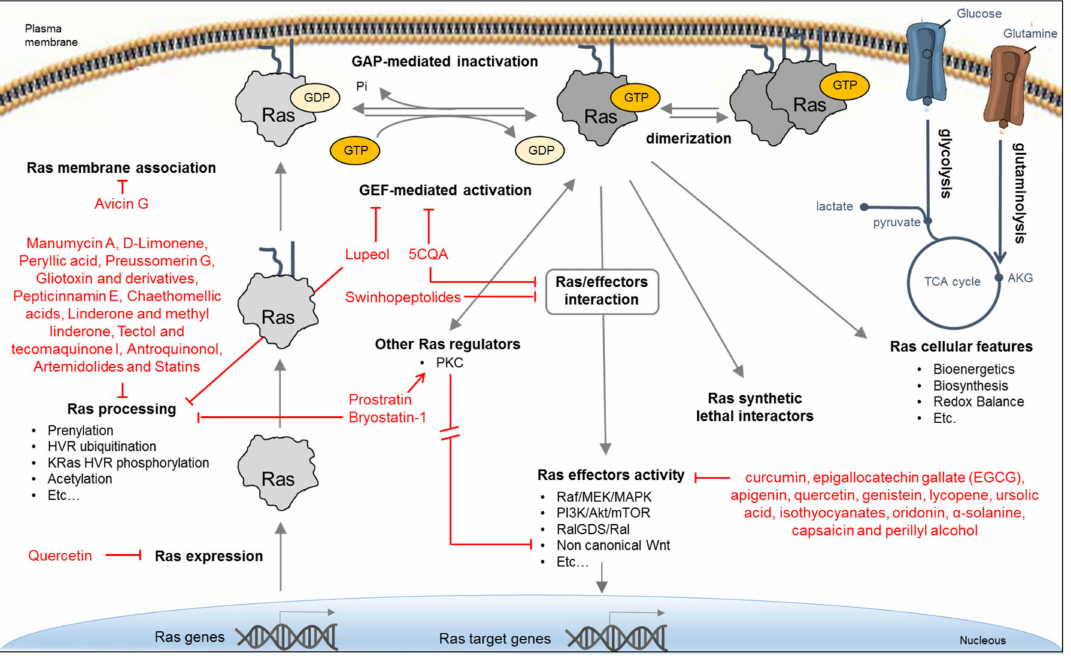
Figure 2. Approaches for inhibiting Ras oncoproteins biosynthesis, processing, activity, and signaling. Indirect Ras inhibitory approaches include the interference with di ff erent processes: expression of Ras oncogenes, Ras processing and membrane localization, activity of Ras regulators, activity of downstream e ff ectors, Ras-dependent cellular features, and the activity of synthetic lethal interactors. Direct Ras inhibitory approaches include the interference with Ras / GEF interaction and exchange activity, Ras / e ff ector interaction, and Ras